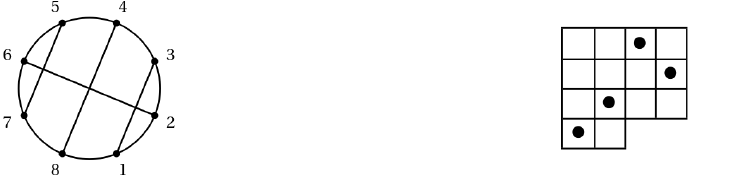
Figure 1 . A lensless strand diagram (left) and folded OG tableau (right) for the permutation (1 3)(2 6)(4 8)(5 7) .